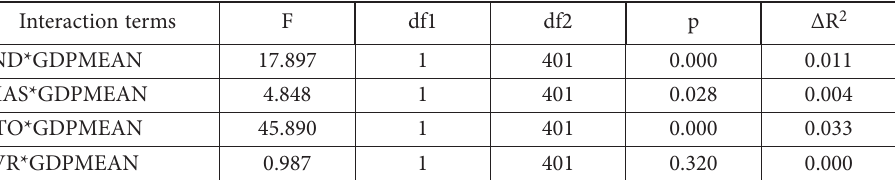
Table 2. Results of interaction